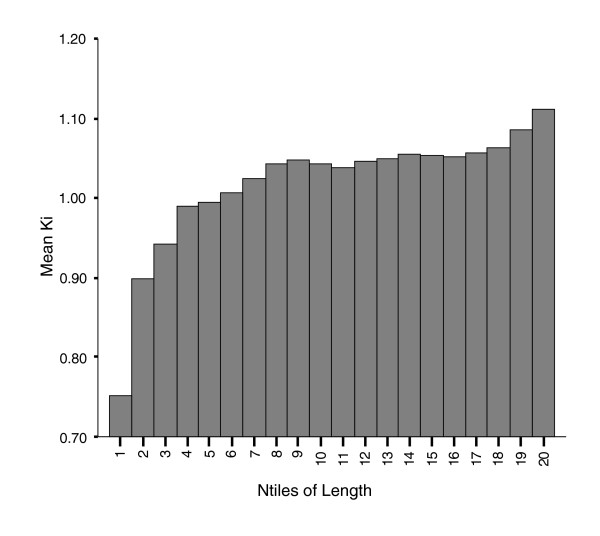
Average Ki for 20 classes of percentiles of length. Although there is a global increase in divergence with size, the shortest class of size presents an especially low divergence compared with all of the following classes of intron size.